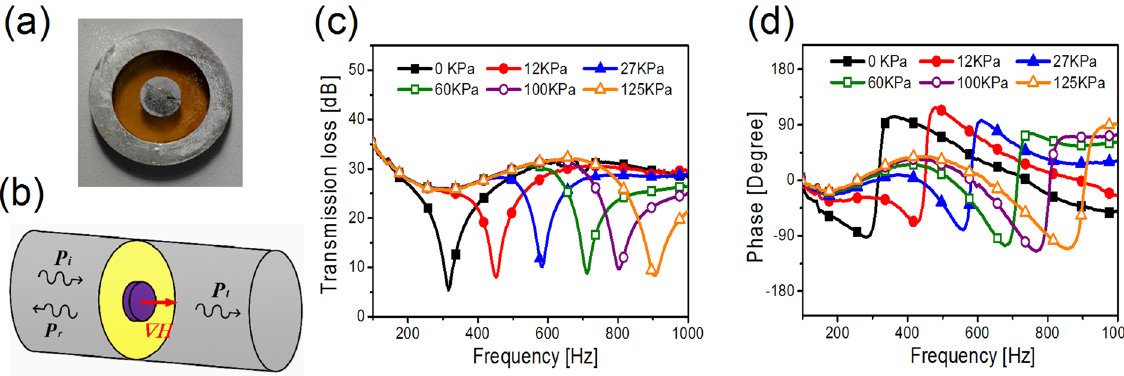
Figure 1. ( a ) Photo of the mass-weighted membrane structure. ( b ) The schematic of the experimental measurement device. ( c ) The measured acoustic transmission loss of the mass-weighted membrane structure under different magnetic forces. ( d ) The measured phase of the mass-weighted membrane structure under different magnetic